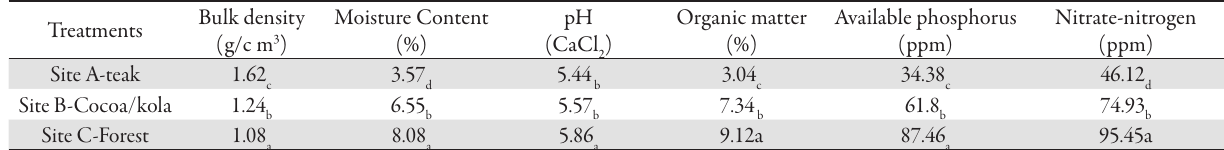
Tab. 3. Soil properties of the study sites